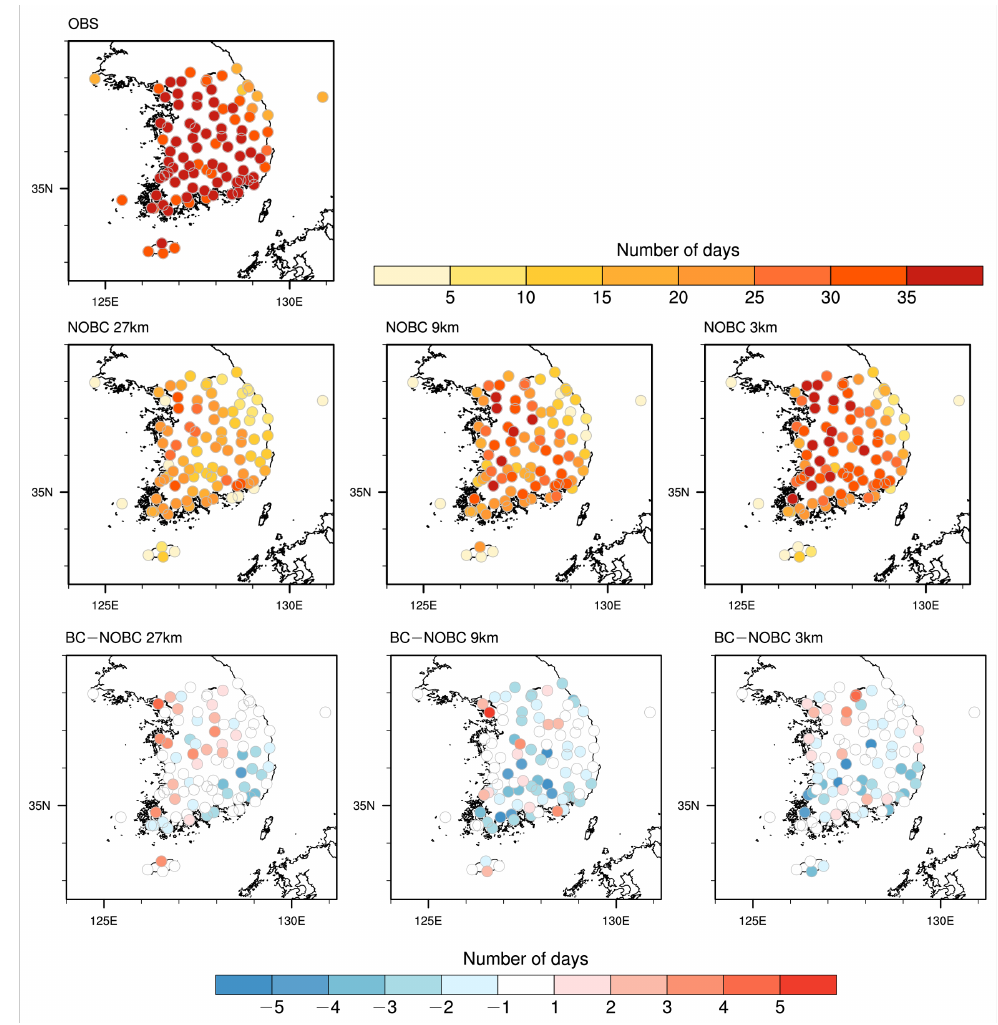
Figure 14. Same as Figure 11, except for CASE